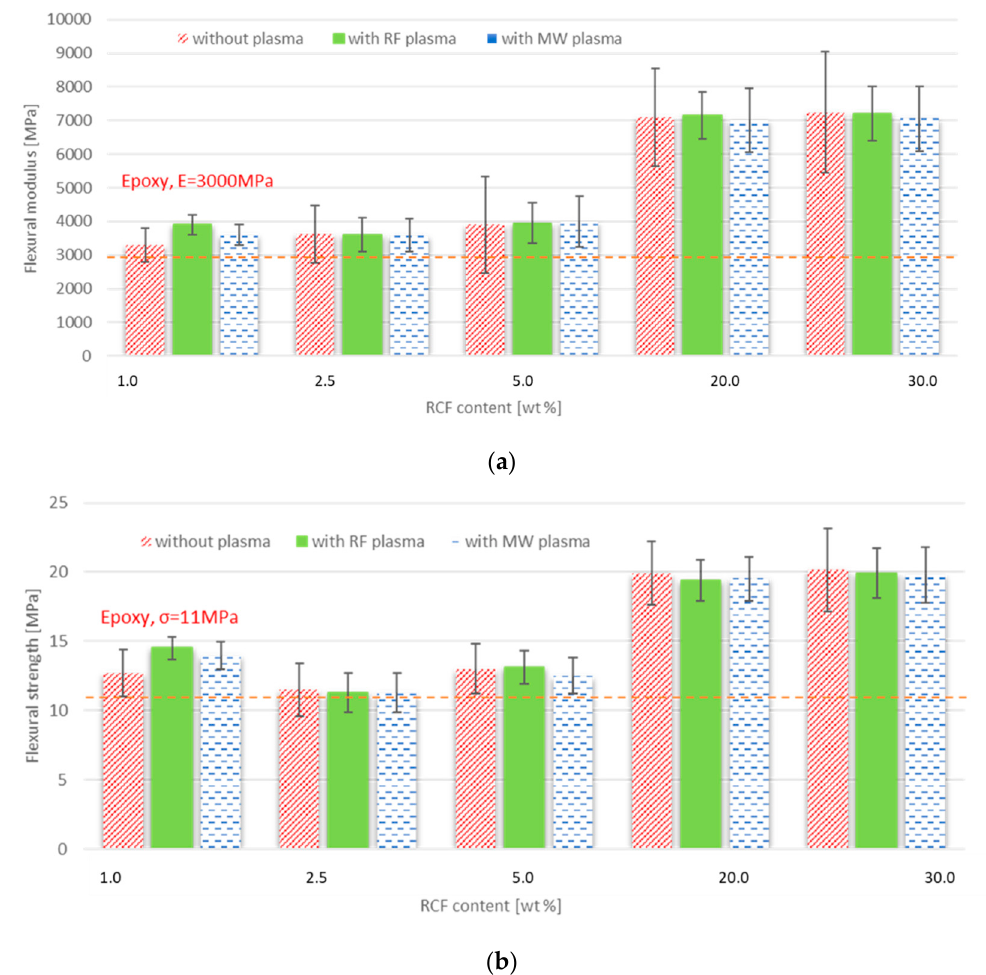
Figure 12. The flexural strength of FRE composites: ( a ) flexural modulus; and ( b ) flexural strength.